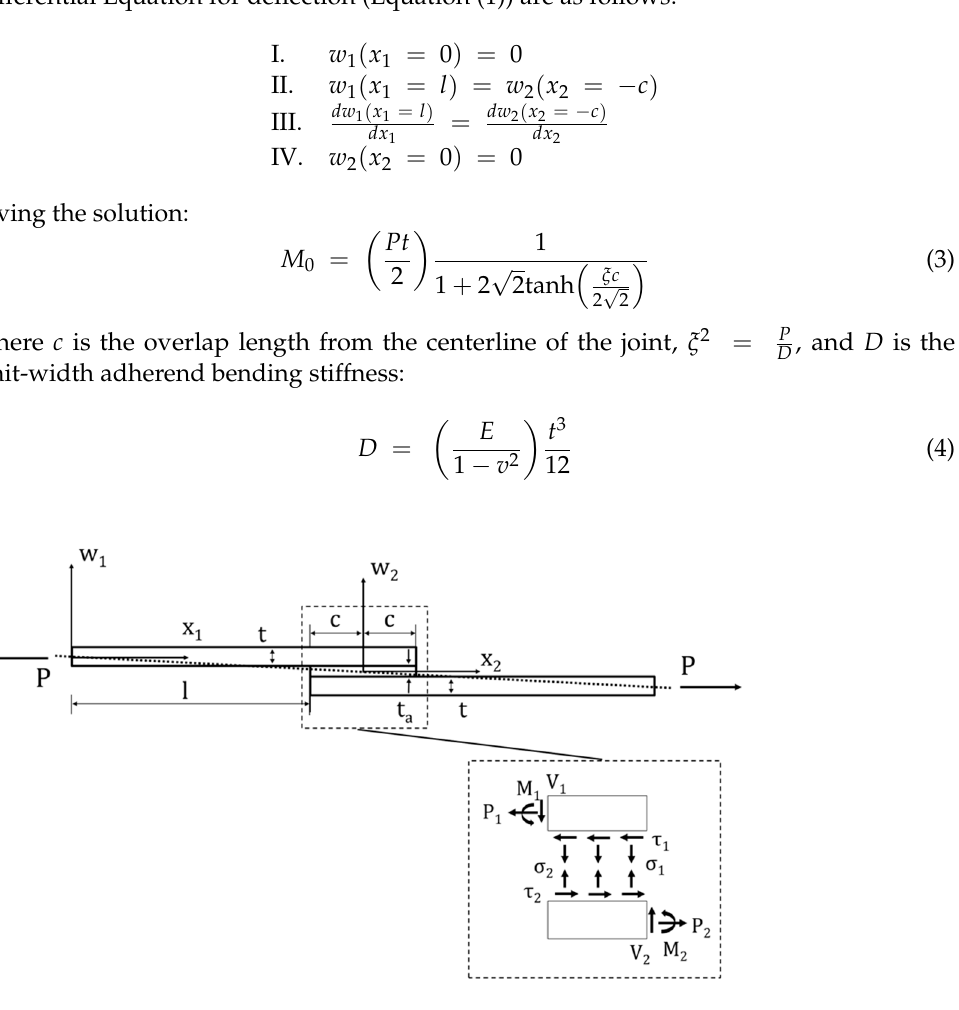
Figure 4. The reference system and critical terms used to model the lap shear joint. Origin for the coordinate system (1) is located at the center of the upper adherend and origin for coordinate system (2) is located at the centroid of the joint.